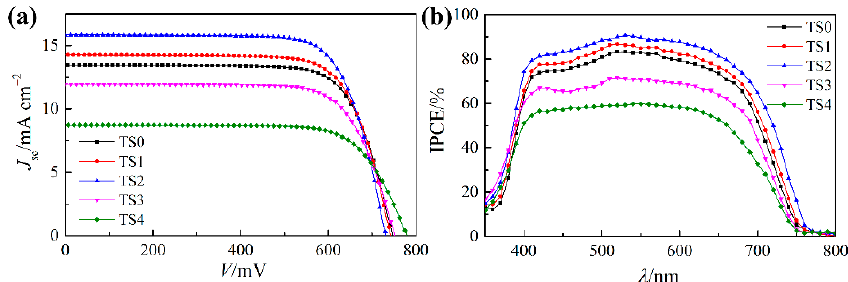
Figure 6. (a) J – V characteristics under an irradiance of 100 mW cm − 2 simulated AM1.5G sunlight and (b) IPCE spectra of DSSC based on pure TiO 2 NWAs (TS0) and Sn-doped TiO 2 NWAs (TS1, TS2, TS3, and TS4).